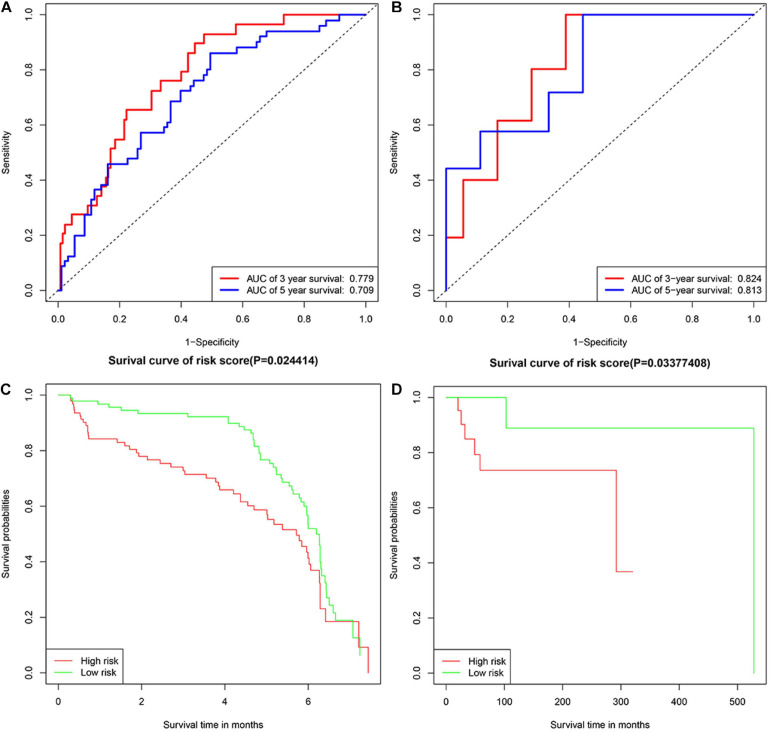
The Kaplan-Meier plotters and ROC curves in validation groups. Panels (A,B) represented Kaplan-Meier plotters in TCGA-DLBC and GSE32918, separately. Panels (C,D) represented ROC curves in TCGA-DLBC and GSE32918, separately.